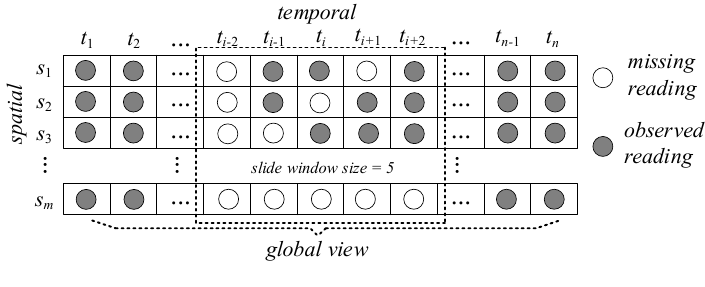
Figure 3. Data matrix of sensor readings.